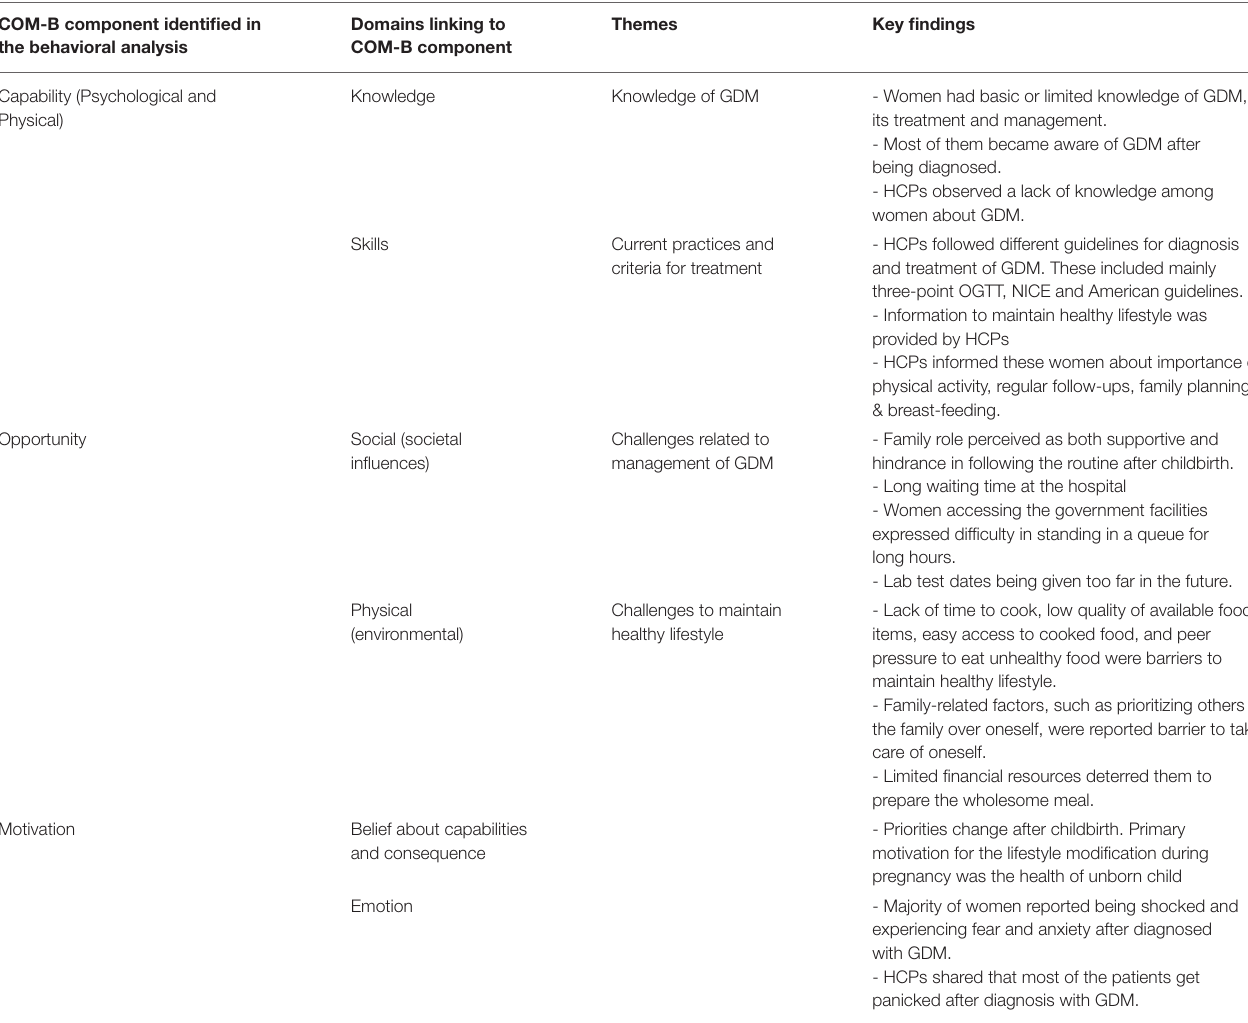
TABLE 3 | COM-B components linked with key findings of LIVING formative